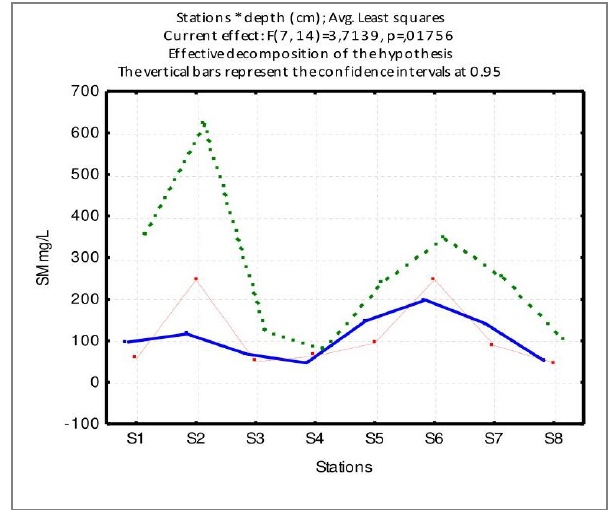
Figure 4. Spatial variation of MS in mg/l in Reghaia Lake. of 4³ˉ